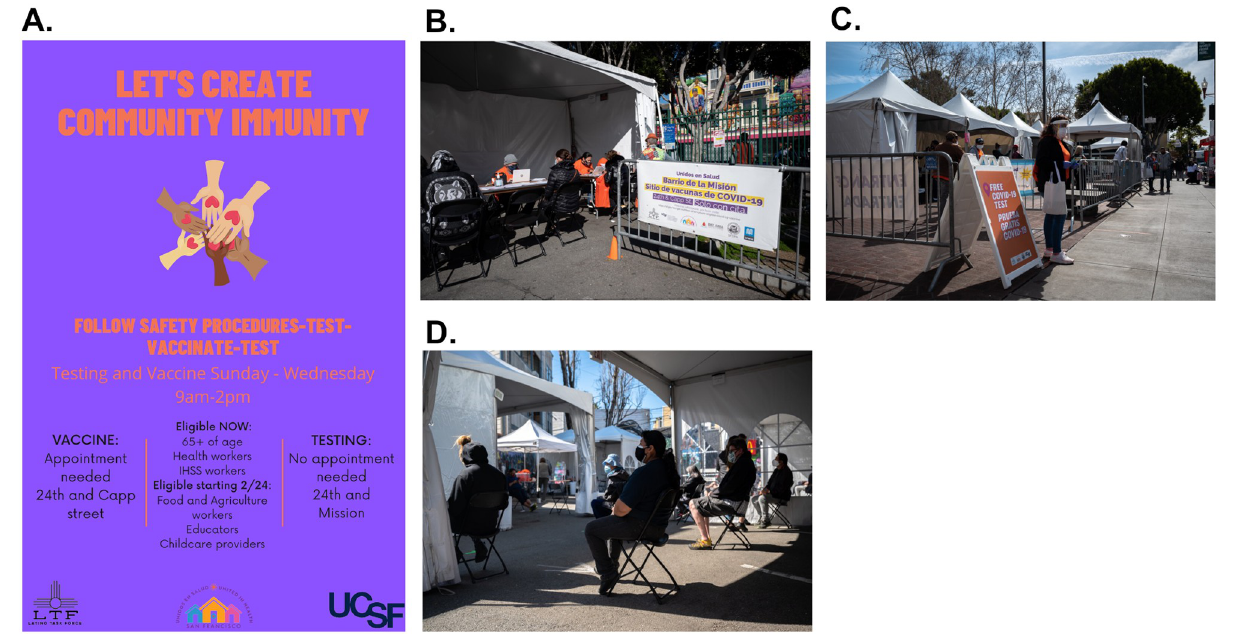
Fig 2. Photographs taken during the implementation period of the “Motivate, Vaccinate and Activate”. Panel A shows an example of flyers promoting COVID-19 vaccination at the Unidos en Salud neighborhood site, posted in English and Spanish. Panel B shows the registration area of the Unidos en Salud low-barrier vaccination site. Panel C shows the Unidos en Salud COVID-19 testing site directly across from the vaccination site. Community members could make vaccination appointments and were also encouraged to drop-in for same-day vaccination. Community members could ask site staff questions about the COVID-19 vaccine and were provided handouts about the COVID-19 vaccine. Panel D shows the waiting area of the Unidos en Salud low-barrier vaccination site where clients were provided education on possible COVID-19 side effects and were also ‘activated’ to the community health team be become vaccine ambassadors to reach out to their unvaccinated family members, friends and co-workers.